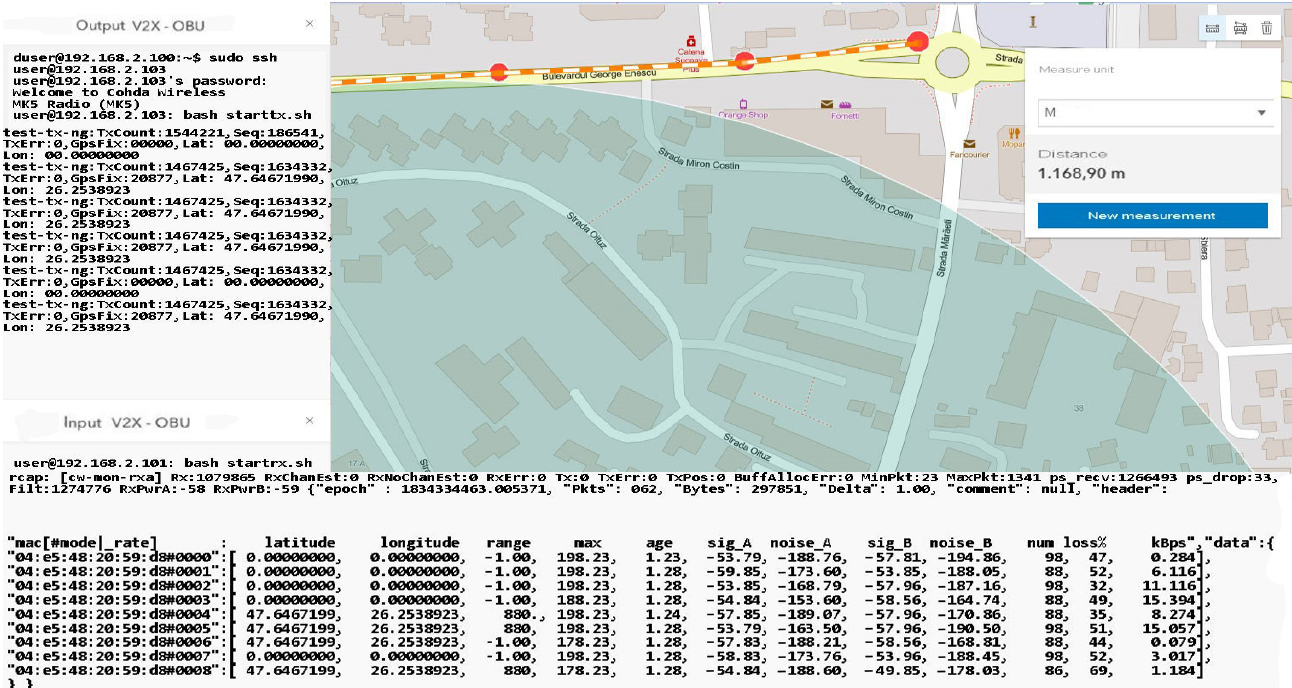
Figure 35. Simulated scenario at a distance of 880m from the transmitter in an environment. Table 7. Simulation scenarios over a distance of over 650 m from reception, data interpretation, loss, data transfer, signal, and noise.